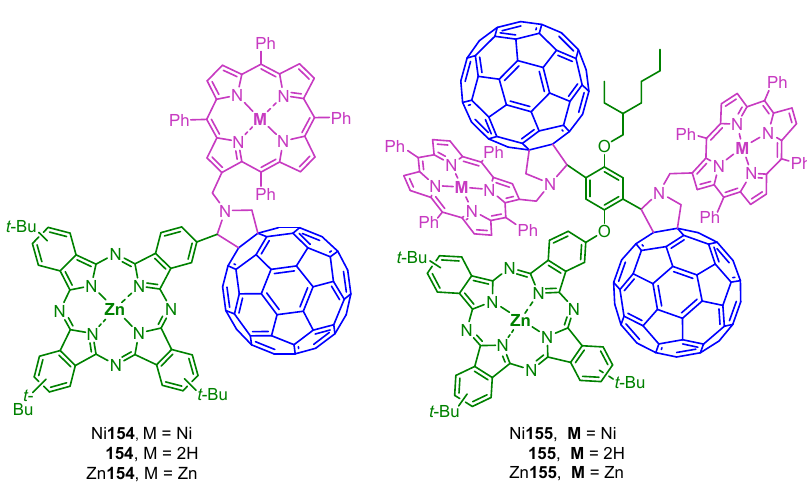
Figure 17. Fullerene-phthalocyanine-porphyrin triads and pentads [161].